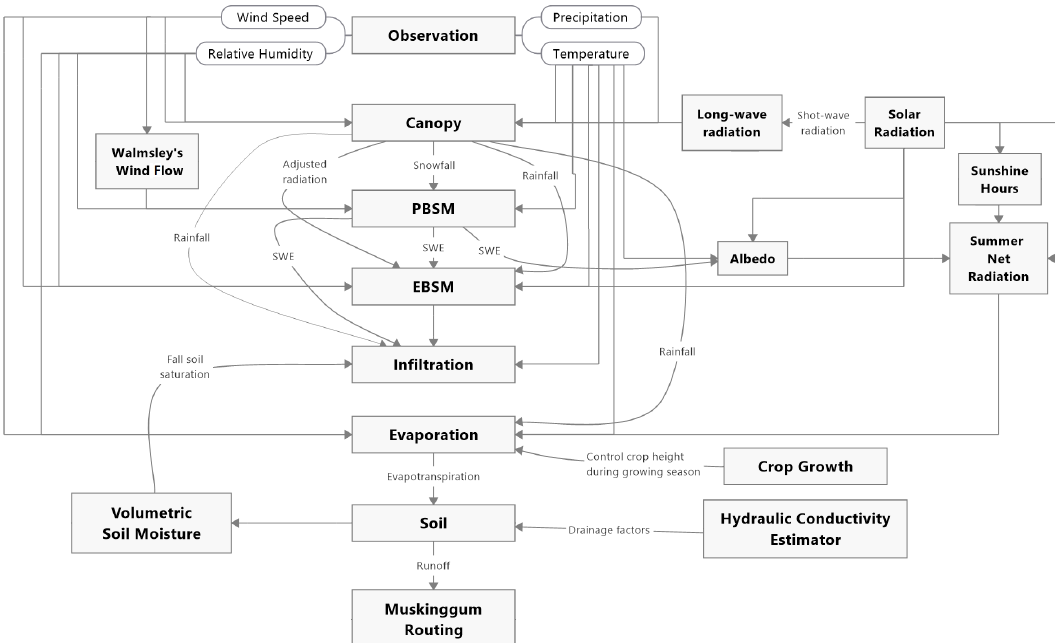
Figure 2. Flowchart of the model structure of CRHM used in this study (adapted from Cordeiro et al., 2017). PBSM represents the Prairie Blowing Snow Module, and EBSM represents the Energy-Budget Snowmelt